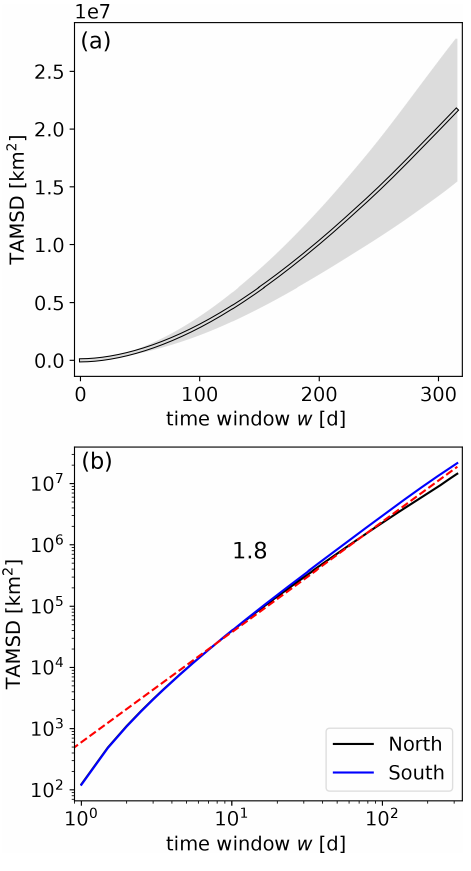
Figure 6. Mean squared displacement (MSD) for the advected parcels in units of km 2 . The spherical geometry was fully taken into account when calculating distances from the initial positions. (a) MSD for the northern subset (lin-lin plot). The error band re- flects the standard deviation obtained from year-by-year statistics. (b) MSDs for both the northern (black) and southern (blue) sub- sets of parcels on a double-logarithmic scale. The dashed red line illustrates a power law with an exponent value of around 1.8.